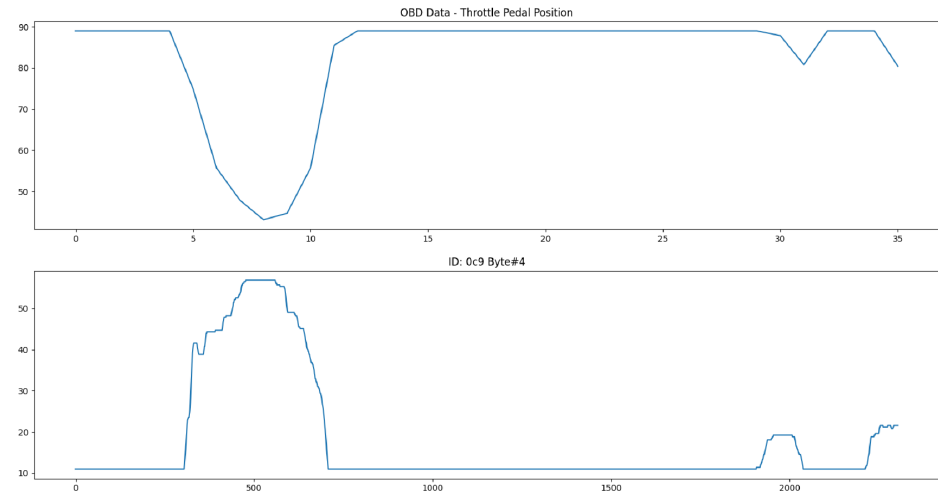
Figure 16. OBD-II data for throttle position ( top ) and the best CAN candidate byte ( bottom ).